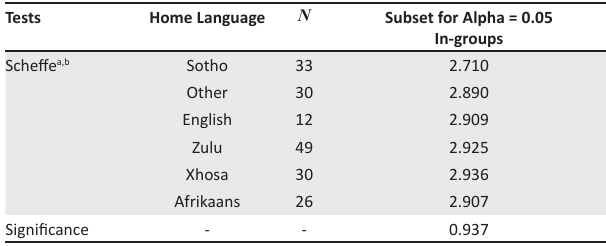
TABLE 6: Homogeneous Subsets for in-group across language groups.